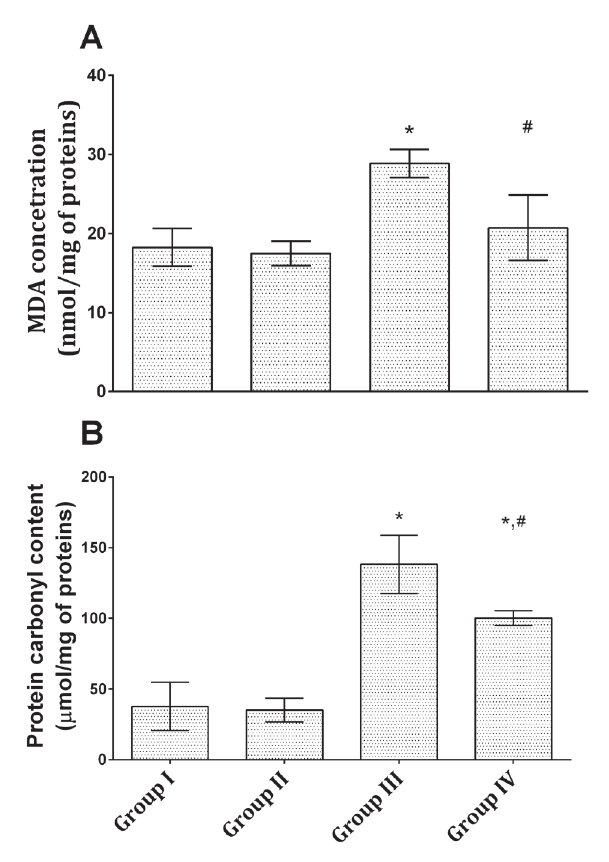
FIGURE 2 - Testicular tissue MDA (A) and carbonylated protein (B) concentrations obtained from different experimental groups. Data are presented as mean ± SD (n=6). *p<0.001 vs. Control (group I), #p<0.001 vs. CCl treated animals (group